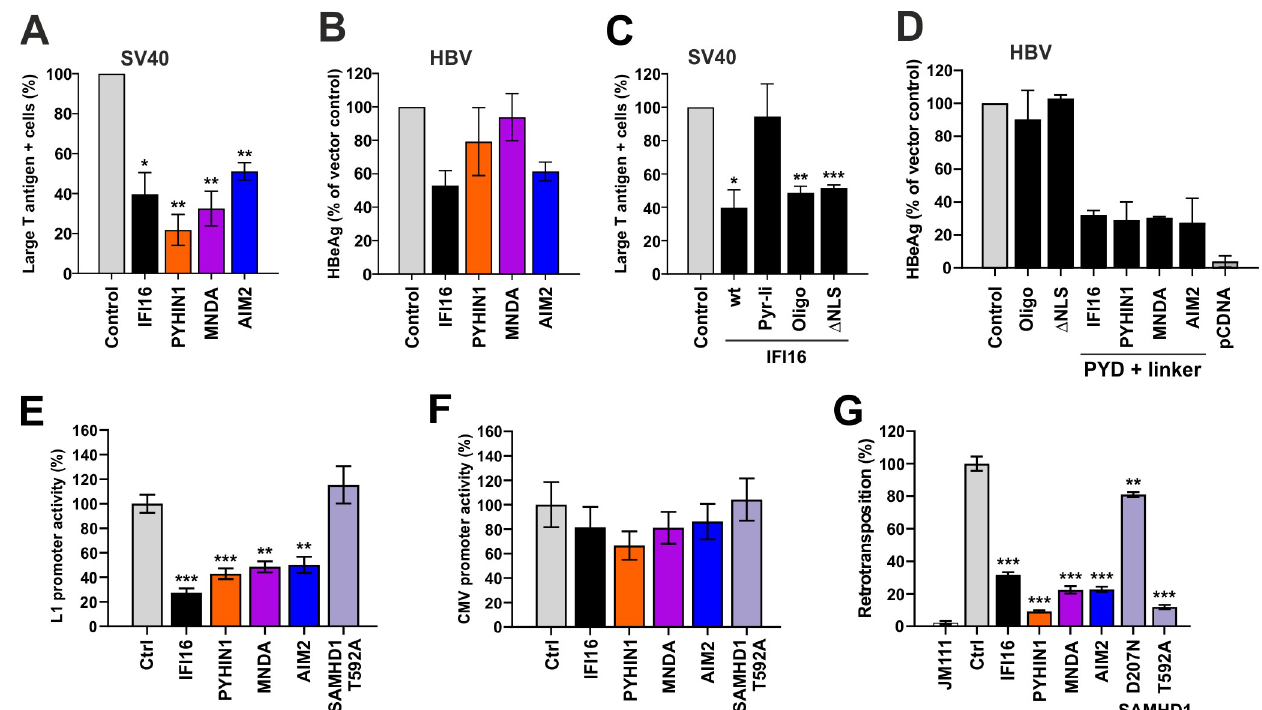
Fig 10. Effect of human PYHIN proteins on various viruses and LINE-1. (A, B) Impact of IFI16, PYHIN1, MNDA and AIM2 on (A) SV40 and (B) HBV infection. An empty vector was used as negative control. (C, D) Determinants of the ability of IFI16 or other human PYHIN proteins to inhibit (C) SV40 and (D) HBV). CV-1 and HepG2 cells were transfected with either an empty vector or expression constructs for full length or the indicated mutants of IFI16 and PYHIN proteins. At 24 h post transfection, cells were infected with SV40 or HBV. SV40 infection was evaluated via intracellular staining of the Large T antigen while HBV replication was assessed by quantification of the HBeAg released into the supernatant. Shown are the results from two to three independent experiments ± SD (E, F) HEK293T cells were cotransfected with (C) LINE-1 or (D) CMV promoter constructs driving luciferase gene expression and expression constructs for IFI16 or a control vector. Luciferase activities (relative light units, RLU) in cell lysates were determined two days later (n = 3 ± SEM). (G) HEK293T cells were cotransfected with a retrotransposition-competent (L1) or -defective (L1 neg) LINE 1-GFP reporter plasmid and a vector control or expression constructs for PYHIN proteins or SAMHD1. Five days post-transfection, GFP+ cells were quantified by flow cytometry (n = 3 ± SEM).